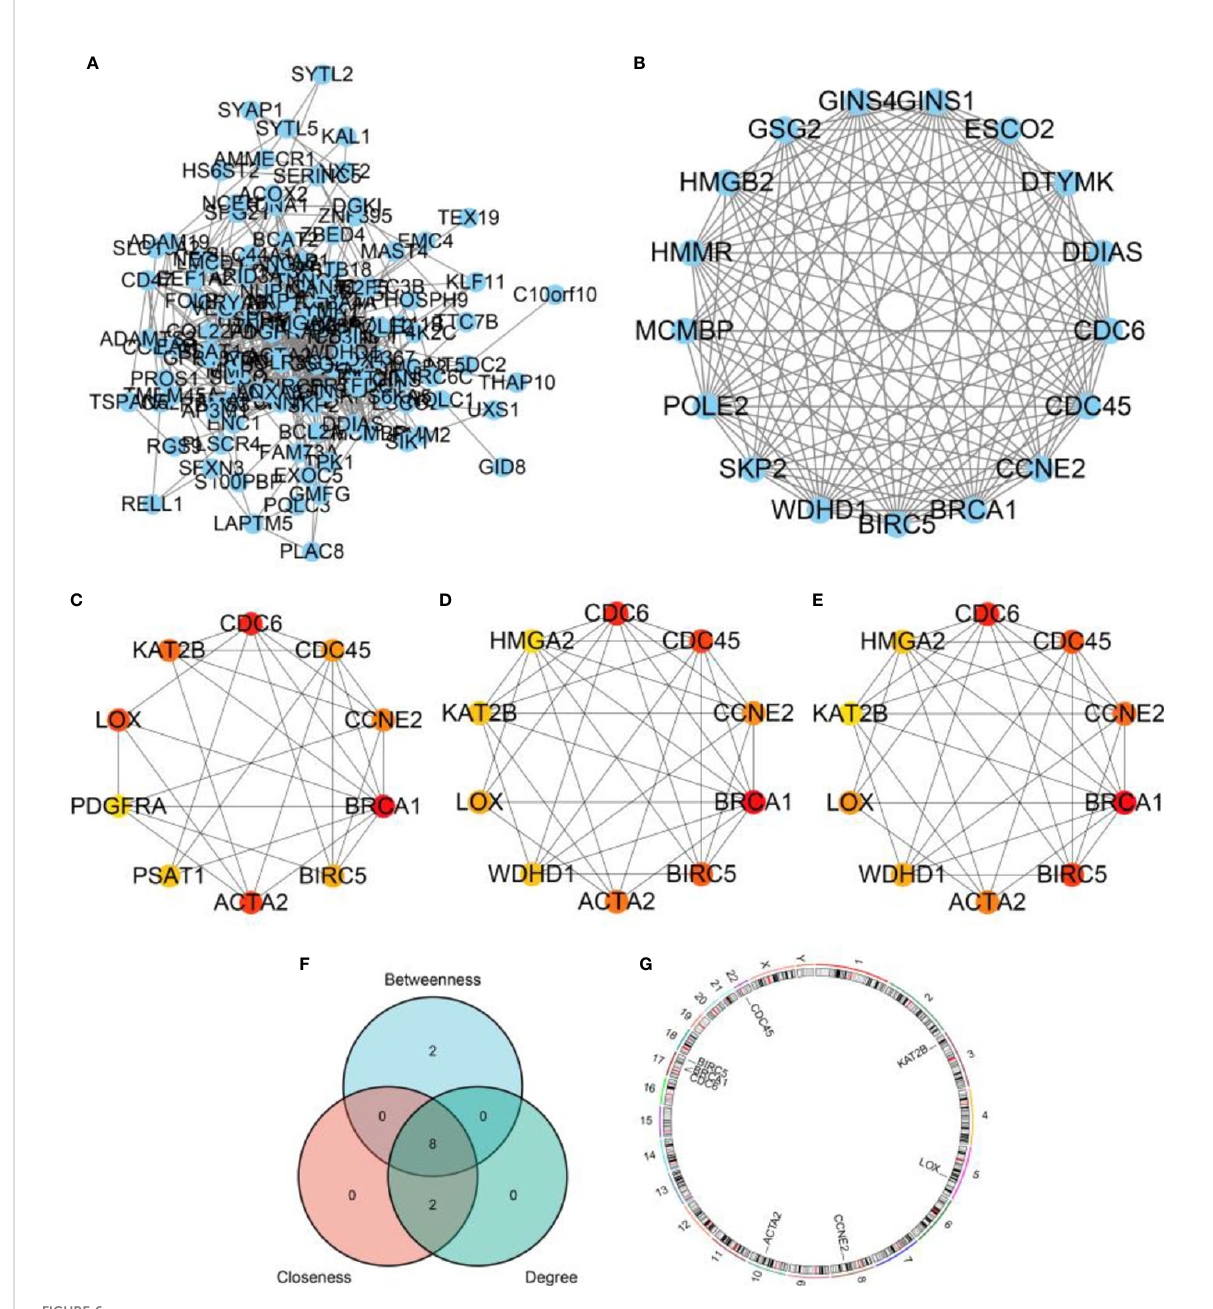
FIGURE 6 PPI network and hub genes. (A) A PPI network based on DEGs. (B) The most signi fi cant cluster found by MCODE plugin in Cytoscape software. (C) Hub genes calculated by Between algorithm. (D) Hub genes calculated by Closeness algorithm. (E) Hub genes calculated by Degree algorithm. (F) A venn diagram displaying overlapped hub genes. (G) The distribution of overlapped hub genes in